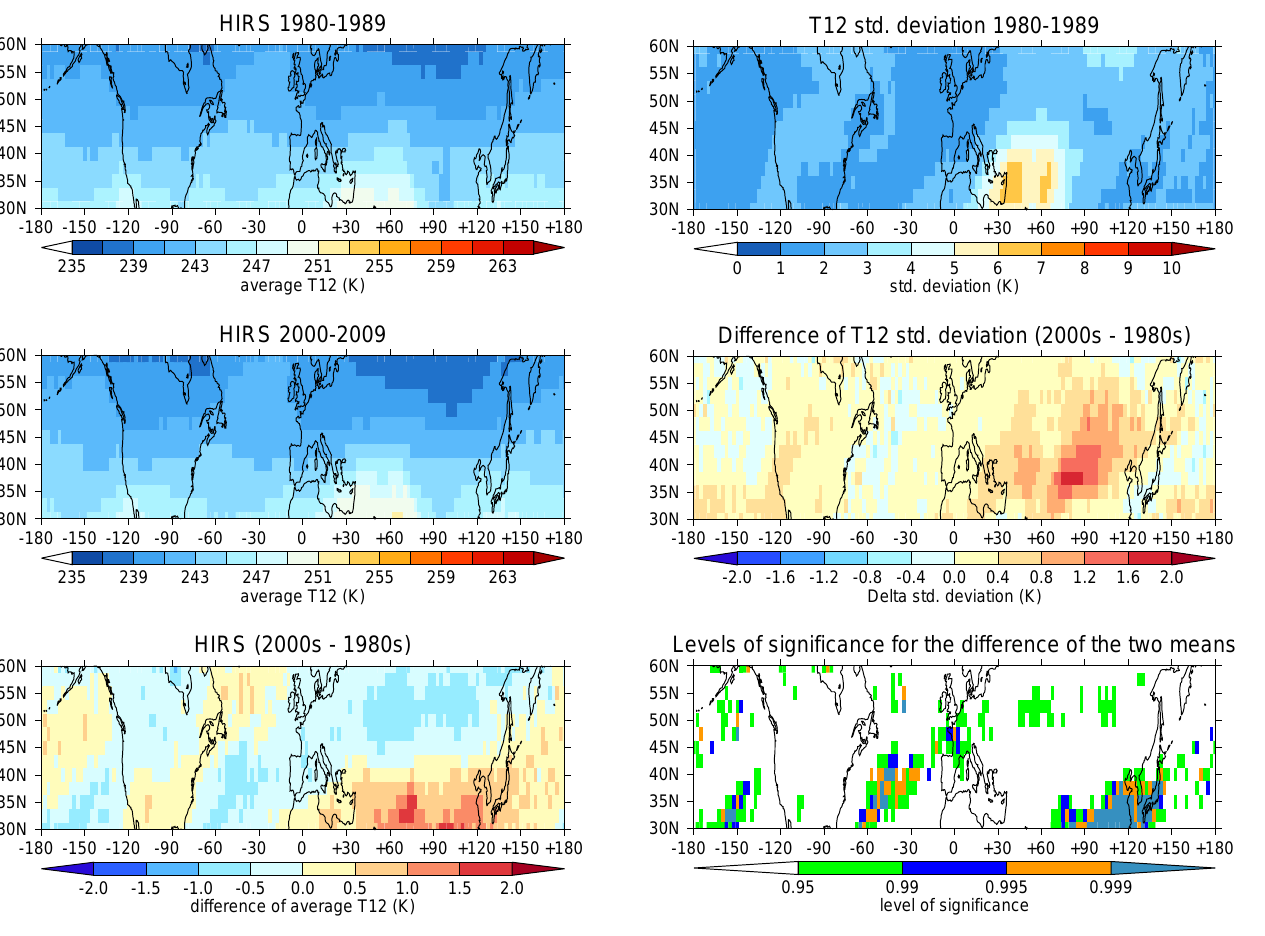
Figure 6. Top panel: map of standard deviations of channel 12 Figure 5. Decadal means of channel 12 brightness temperature for Fig. 6. Top panel: Map of standard variations of channel 12 brightness temperature based on monthly averages for the decade 1980-1989. Fig. 5. Decadal means of channel 12 brightness temperature for the decades 1980-1989 and 2000-2009 and the difference of these means Middle panel: Map of the change of these standard variations between 2000-2009 and 1980-1989. Bottom panel: Statistical significance brightness temperature based on monthly averages for the decade from all available HIRS observations during the respective periods. Resolution as in figure 3. the decades 1980–1989 and 2000–2009 and the difference of these values for the difference of two decadal means of T 12 based on t-tests with unequal variances for each pixel. Resolution as in figure 3. 1980–1989. Middle panel: map of the change of these standard vari- means from all available HIRS observations during the respective ations between 2000–2009 and 1980–1989. Bottom panel: statisti- periods. Resolution as in Fig. 3. cal significance values for the difference of two decadal means of T 12 based on t tests with unequal variances for each pixel. Resolu- tion as in Fig.